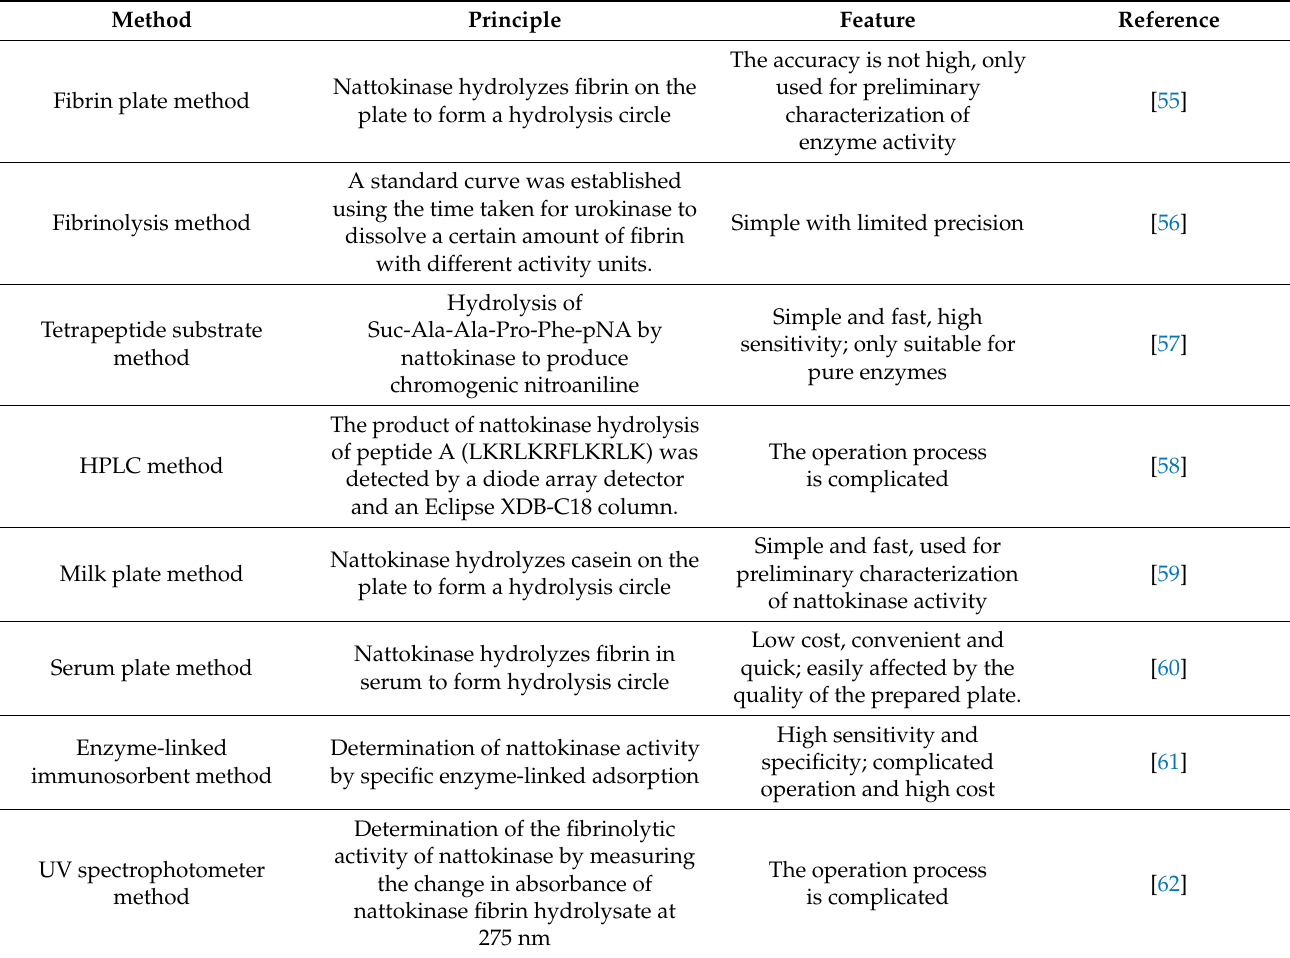
Table 3. Methods of nattokinase activity